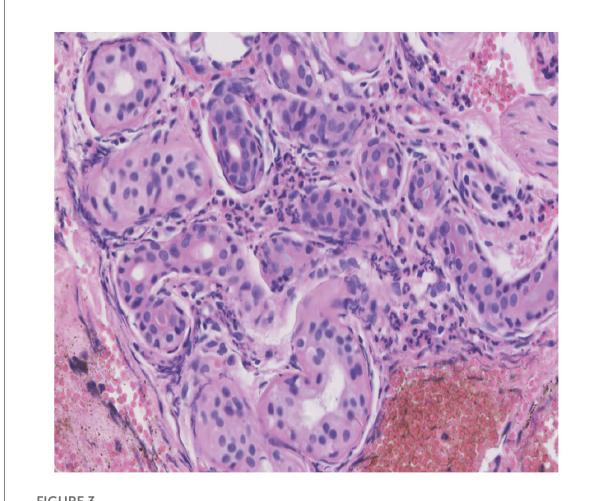
FIGURE 3 Mutation sites detected in the